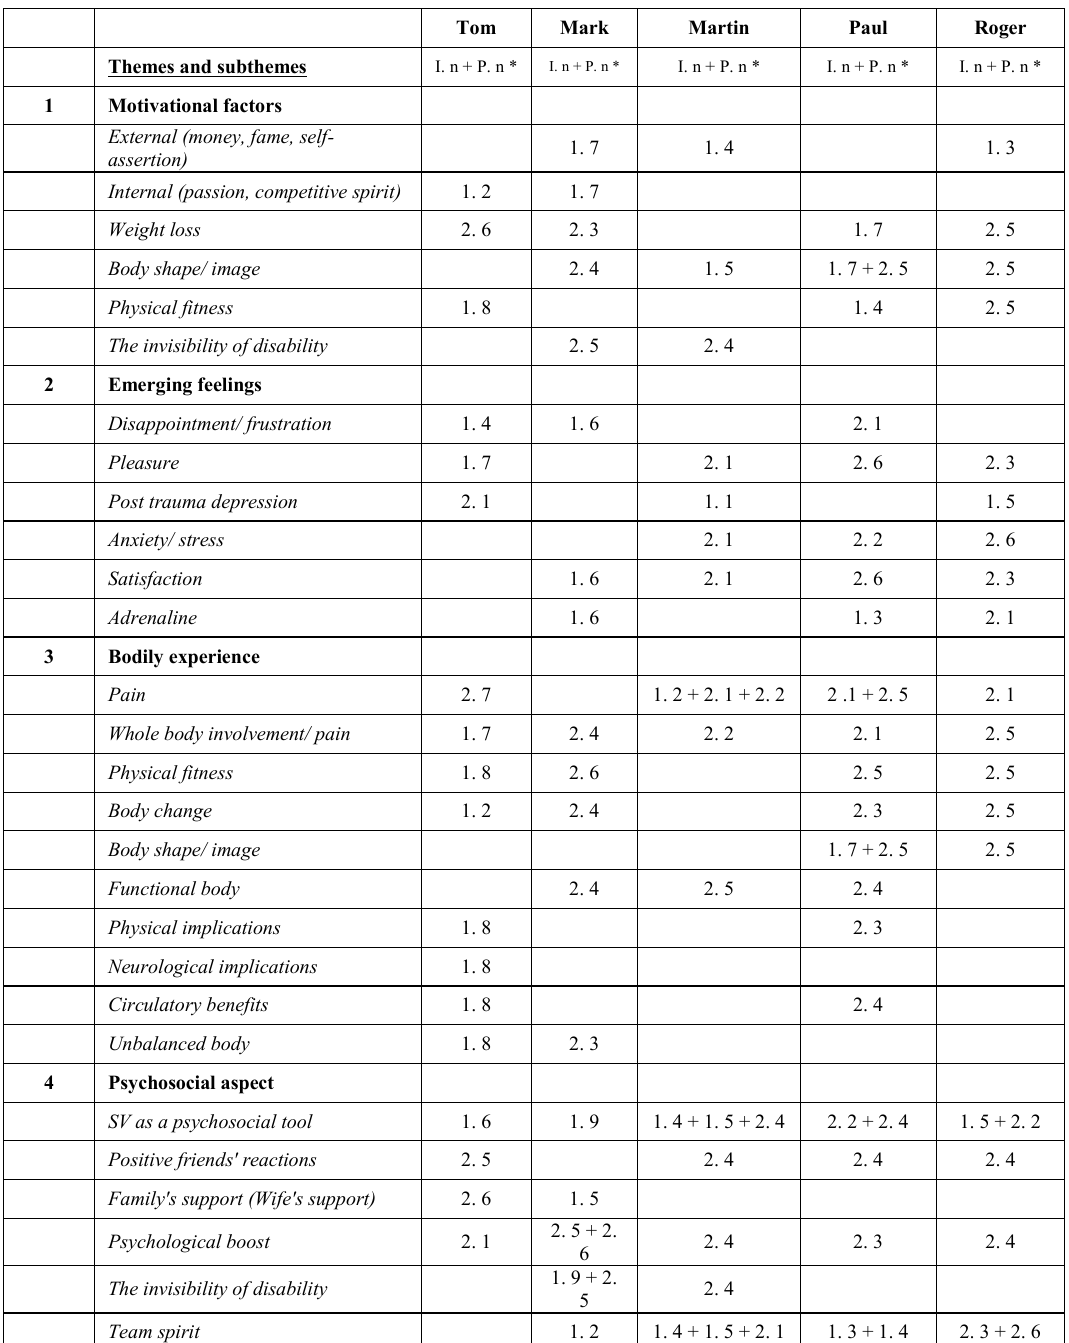
Table 1. Master table of emerging